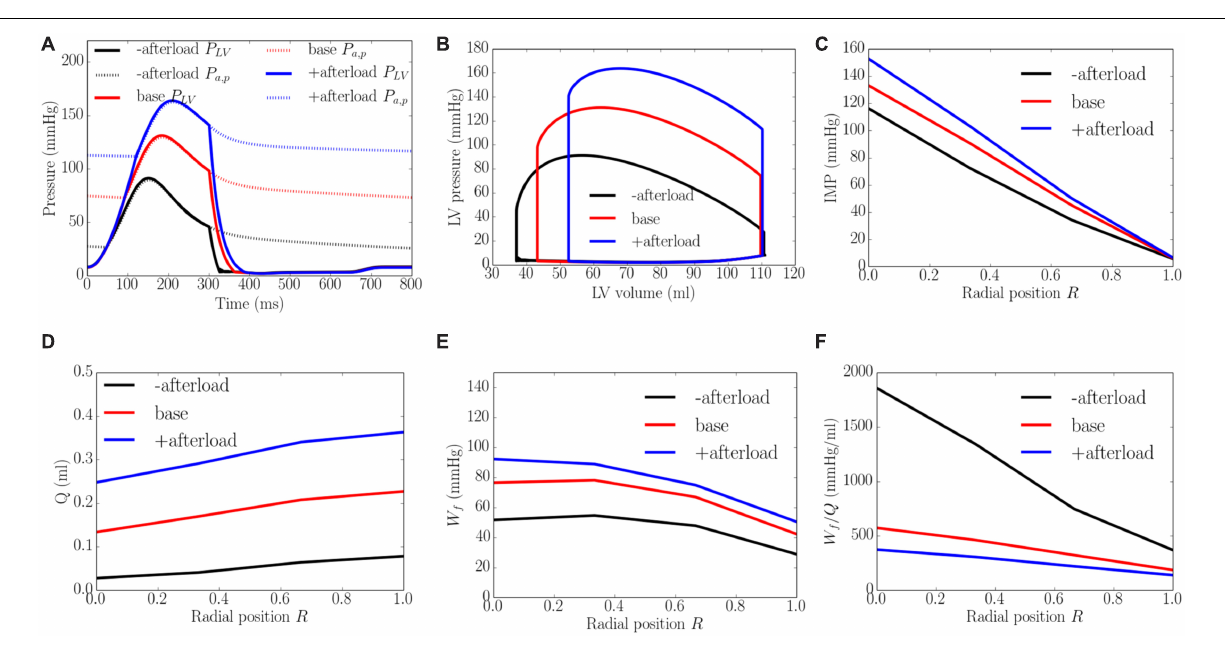
FIGURE 6 | Effects of afterload on (A) Pressure waveforms; (B) LV pressure-volume loop; Transmural distribution of (C) IMP; (D) Total coronary flow over a cardiac cycle; (E) Work density over a cardiac cycle W f ; (F) Work density-perfusion mismatch index ratio W f / Q . “-afterload,” “base,” and “+afterload” denote reduced afterload, baseline, and increased afterload